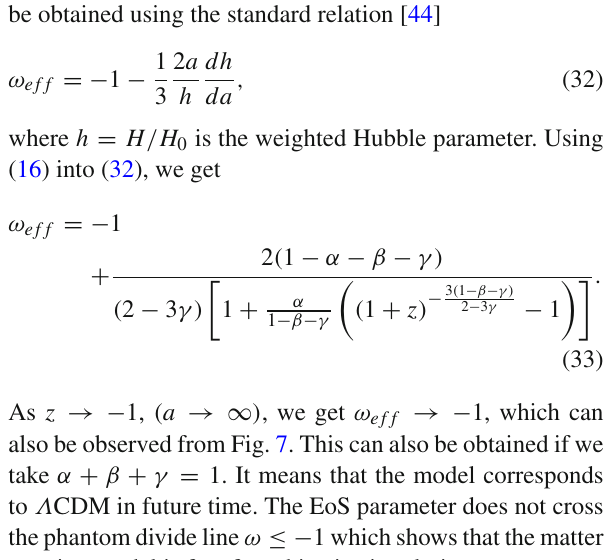
error bars of free parameters are relatively large in the case of SNe